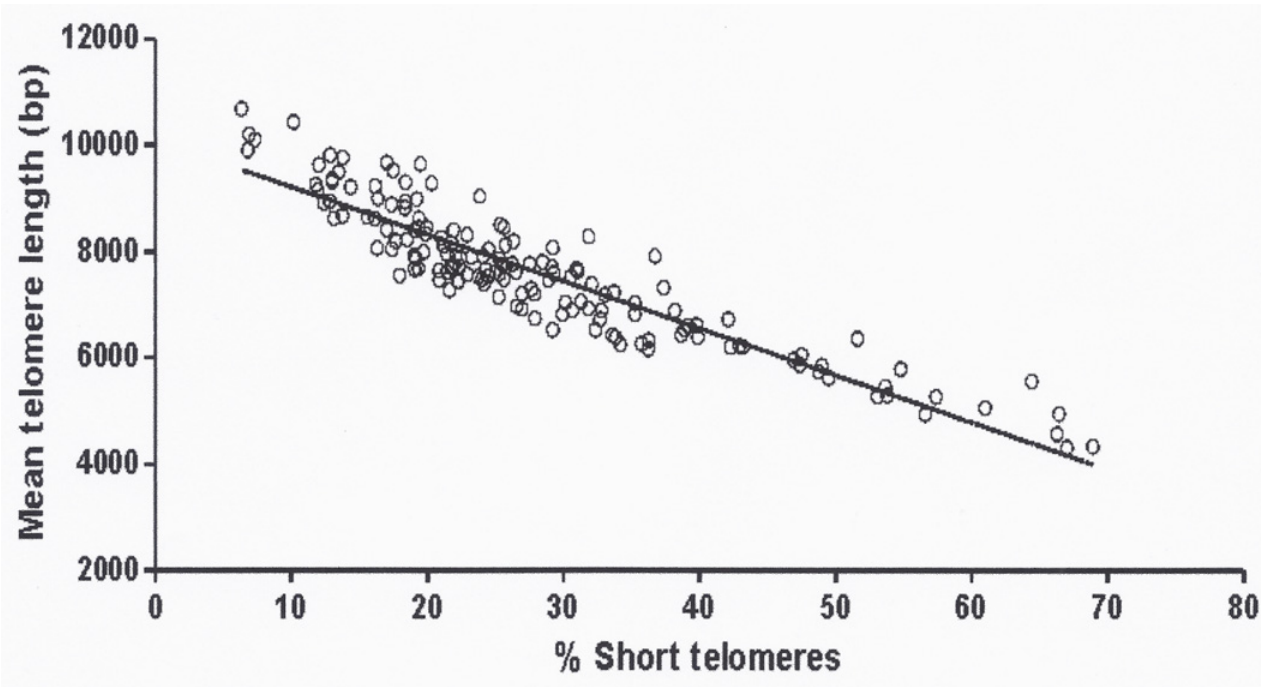
Fig 1. Correlation between mean telomere length and proportion of short telomeres ( < 5kb) in the study population (r-0.917, p <